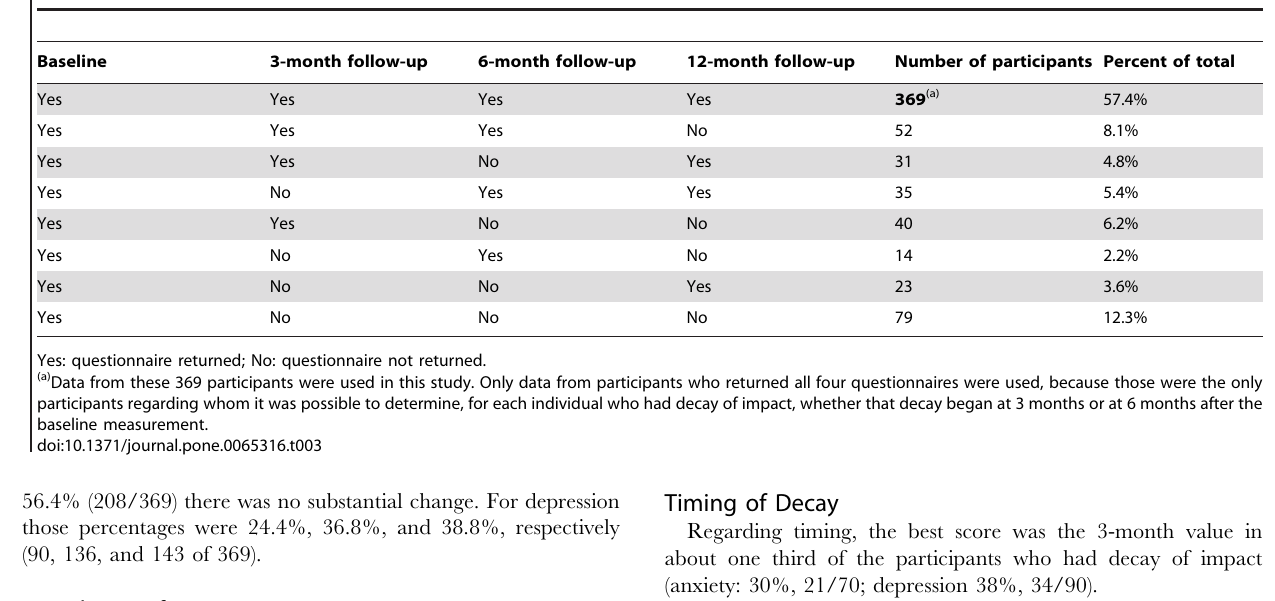
Table 3. Eight patterns of questionnaire return.